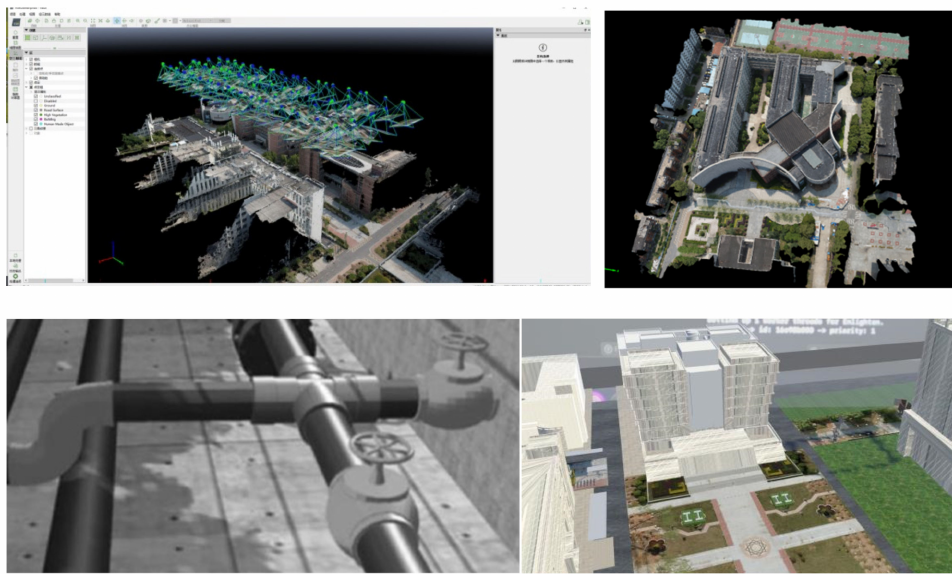
Figure 7. Point cloud modeling and artificial